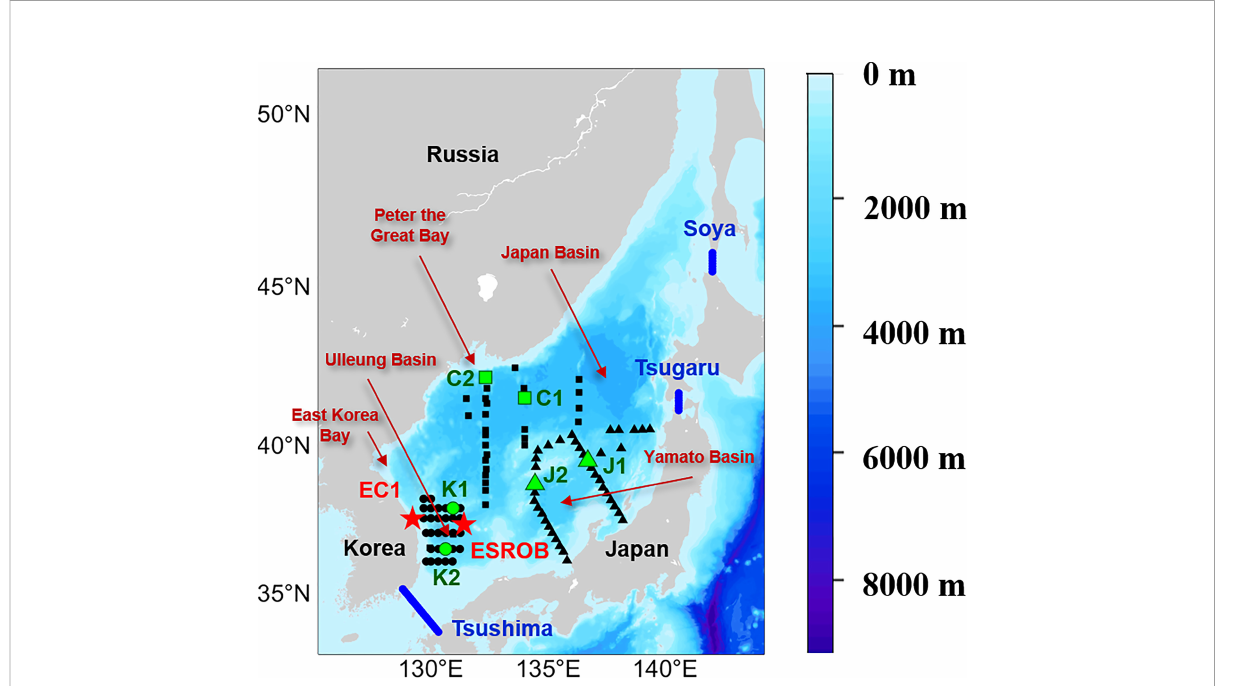
FIGURE 1 Locations of the used monitoring stations for the assessment of temperature and salinity (green marks) and current velocities (red pentagons) as well as the analyzed transects in three major straits (blue lines). Black marks denote hydrographic stations with more than 36 months of observation data. Round, square, and triangle circles denote KODC stations, CREAMS/EAST-I cruise stations, and JMA cruise stations, respectively. The background blue shading shows the bathymetry (m) from ETOPO1. See text for further